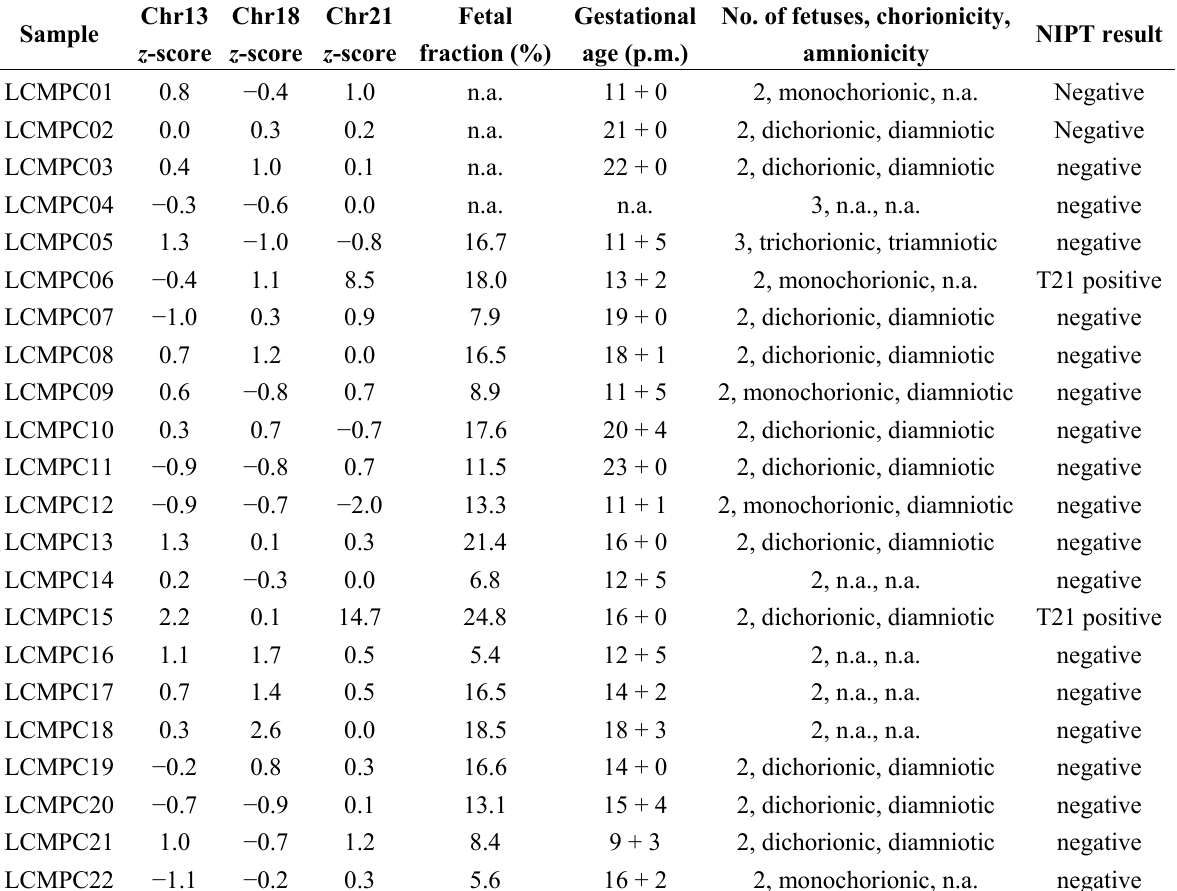
Table 2. Characteristics and NIPT results for the prospectively collected blood